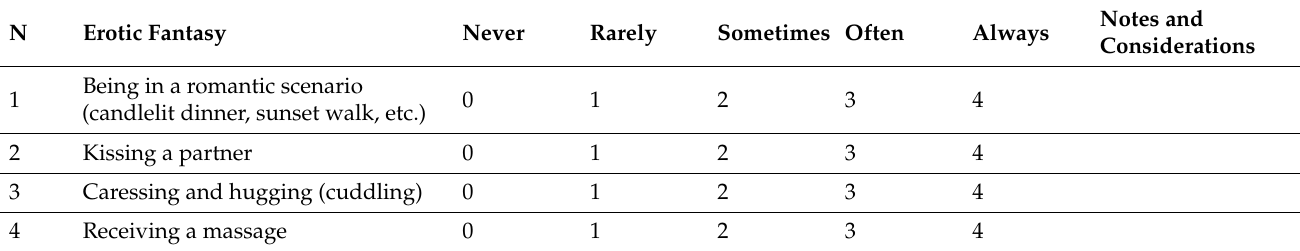
Table A1. SDEF–Sexual Desire and Erotic Fantasies